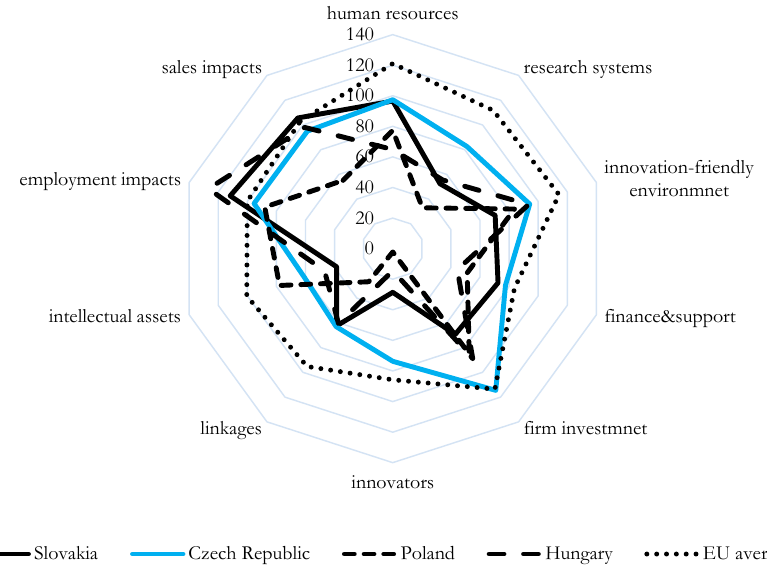
Fig. 2 – SII Dimensions in 2016. Source: own processing according to the European Innovation